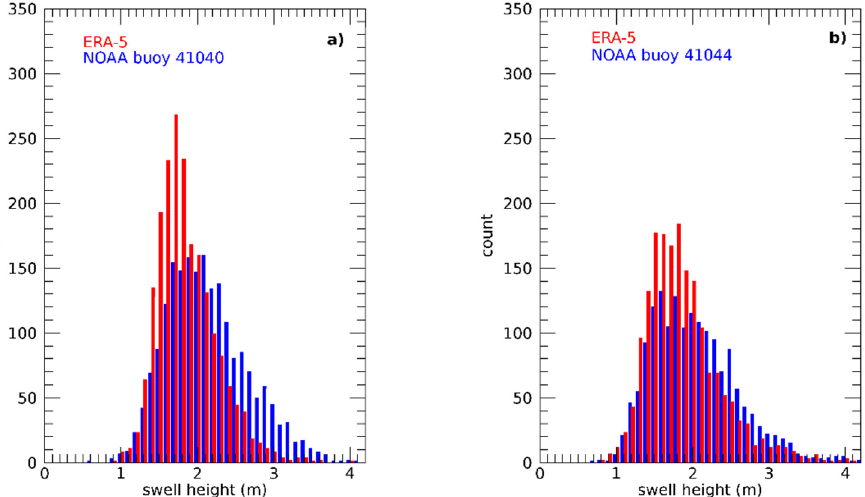
Figure 4. Count of daily swell height for ERA5 estimates and NOAA buoys ( a ) 41040 and ( b ) 41044.